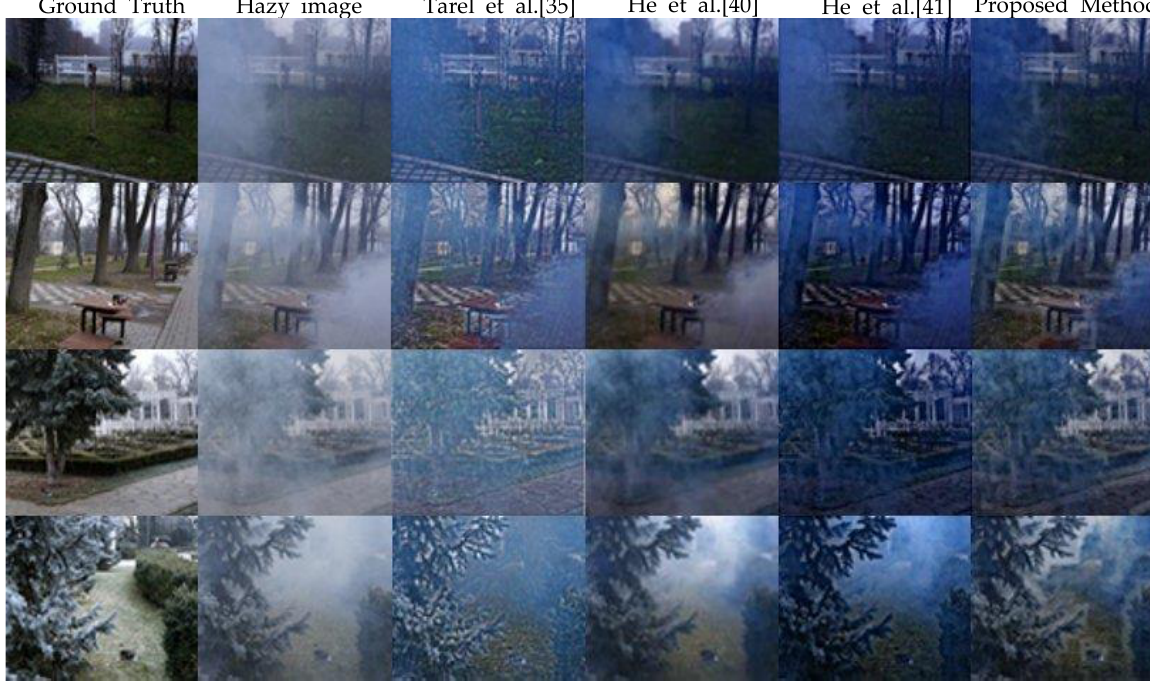
Figure 7. Comparative test results of different dehazing methods using NH-HAZE dataset with Tarel and Hautiere [35], He et al. [40], He et al. [41], and the proposed method.